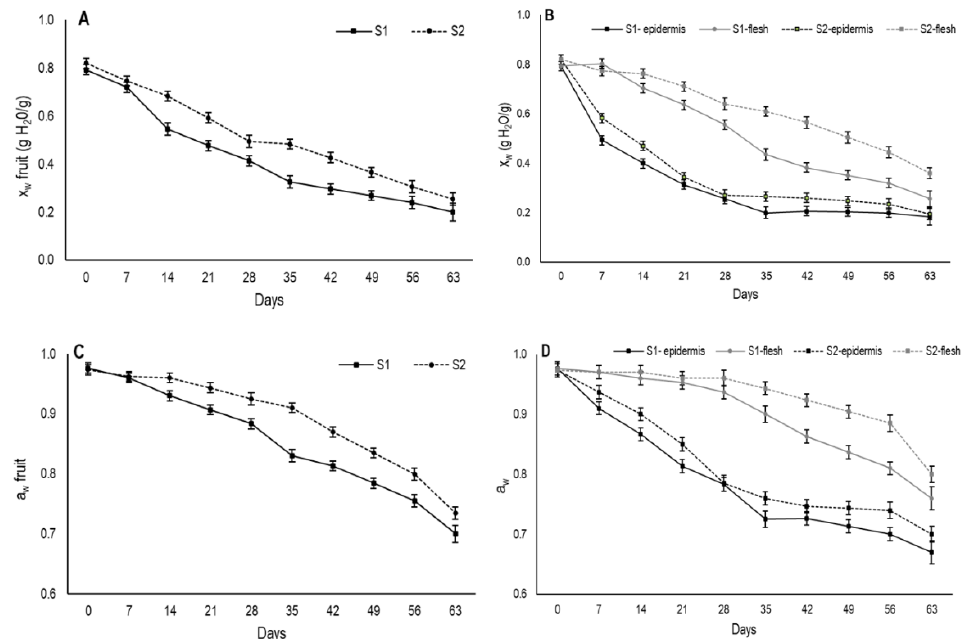
Figure 3. Changes in ( A , B ) moisture (x w ) and ( C , D ) water activity (a w ) of whole fruit and by parts (secondary epidermis and internal flesh) during the drying process of persimmon cv. Rojo Brillante in two maturity stages (S1 and S2). Vertical bars represent Least Significant Differences (LSD) intervals ( p ≤ 0.05).